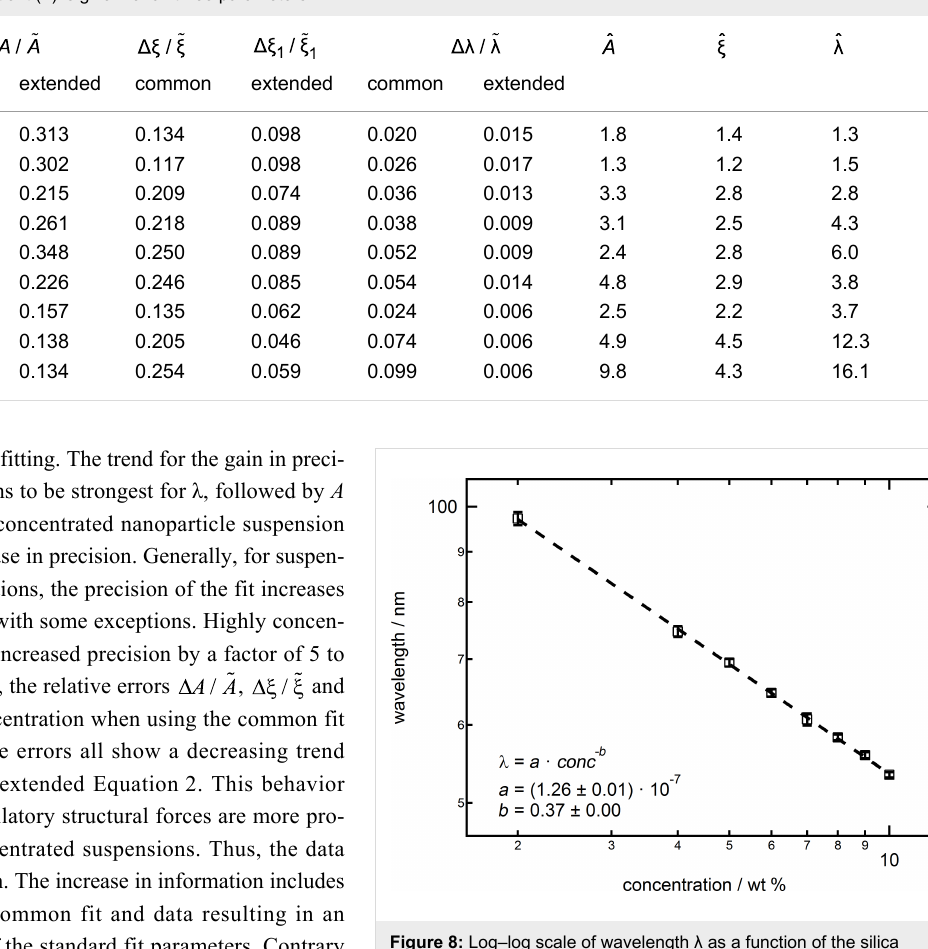
is calculated from the ion concentration induced by the silica nanoparticle number density assuming a charge per particle of Z = 35 [7,9,27]. Zeng et al. already mentioned that this is not tions and ionic